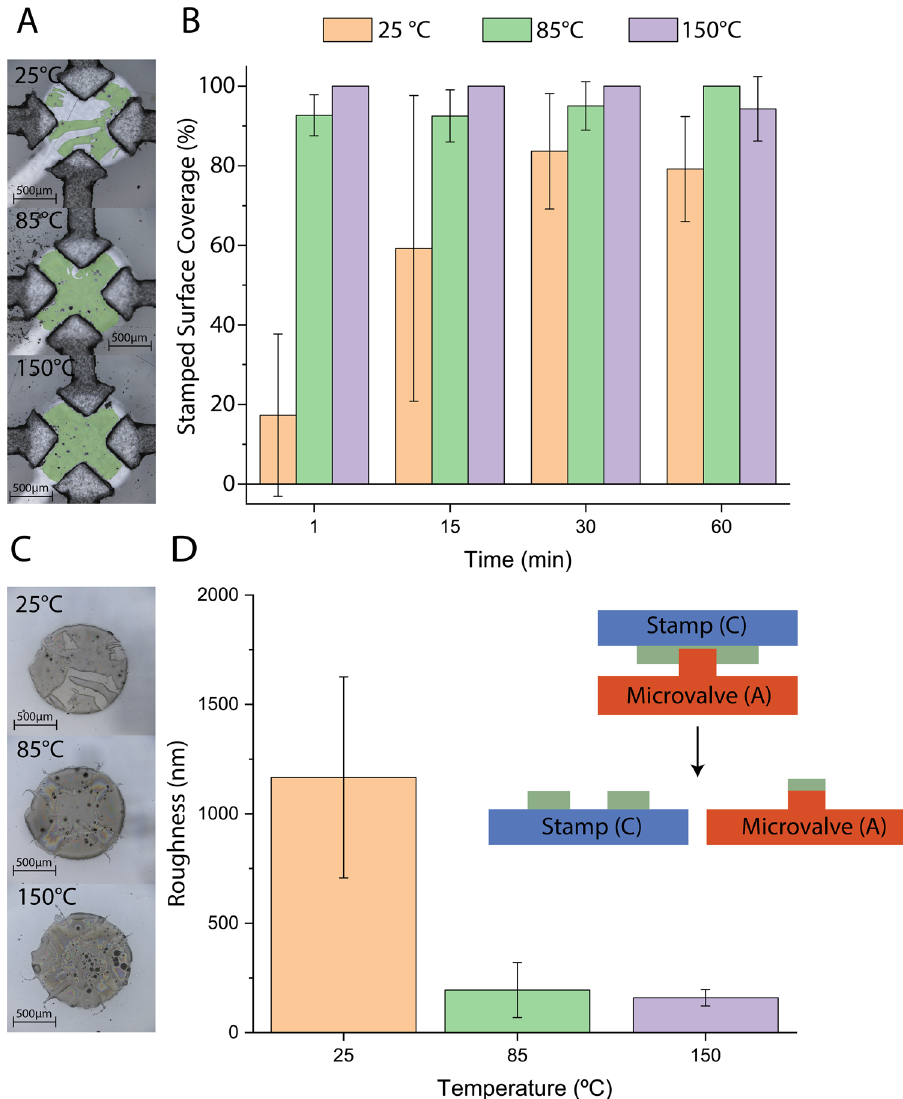
Figure 3. Characterization of PDMS-PDMS stamping to a cross pattern. ( A) Image of the cross after stamping with PFTCS highlighted in green. ( B ) Surface coverage with respect to stamping time and temperature. ( C ) Image of the corresponding stamps after stamping for 30 min. ( D ) Average RMS height across three locations of each stamp showing the uniformity of transfer. Inset image describes where A and C where obtained. All experiments were performed in